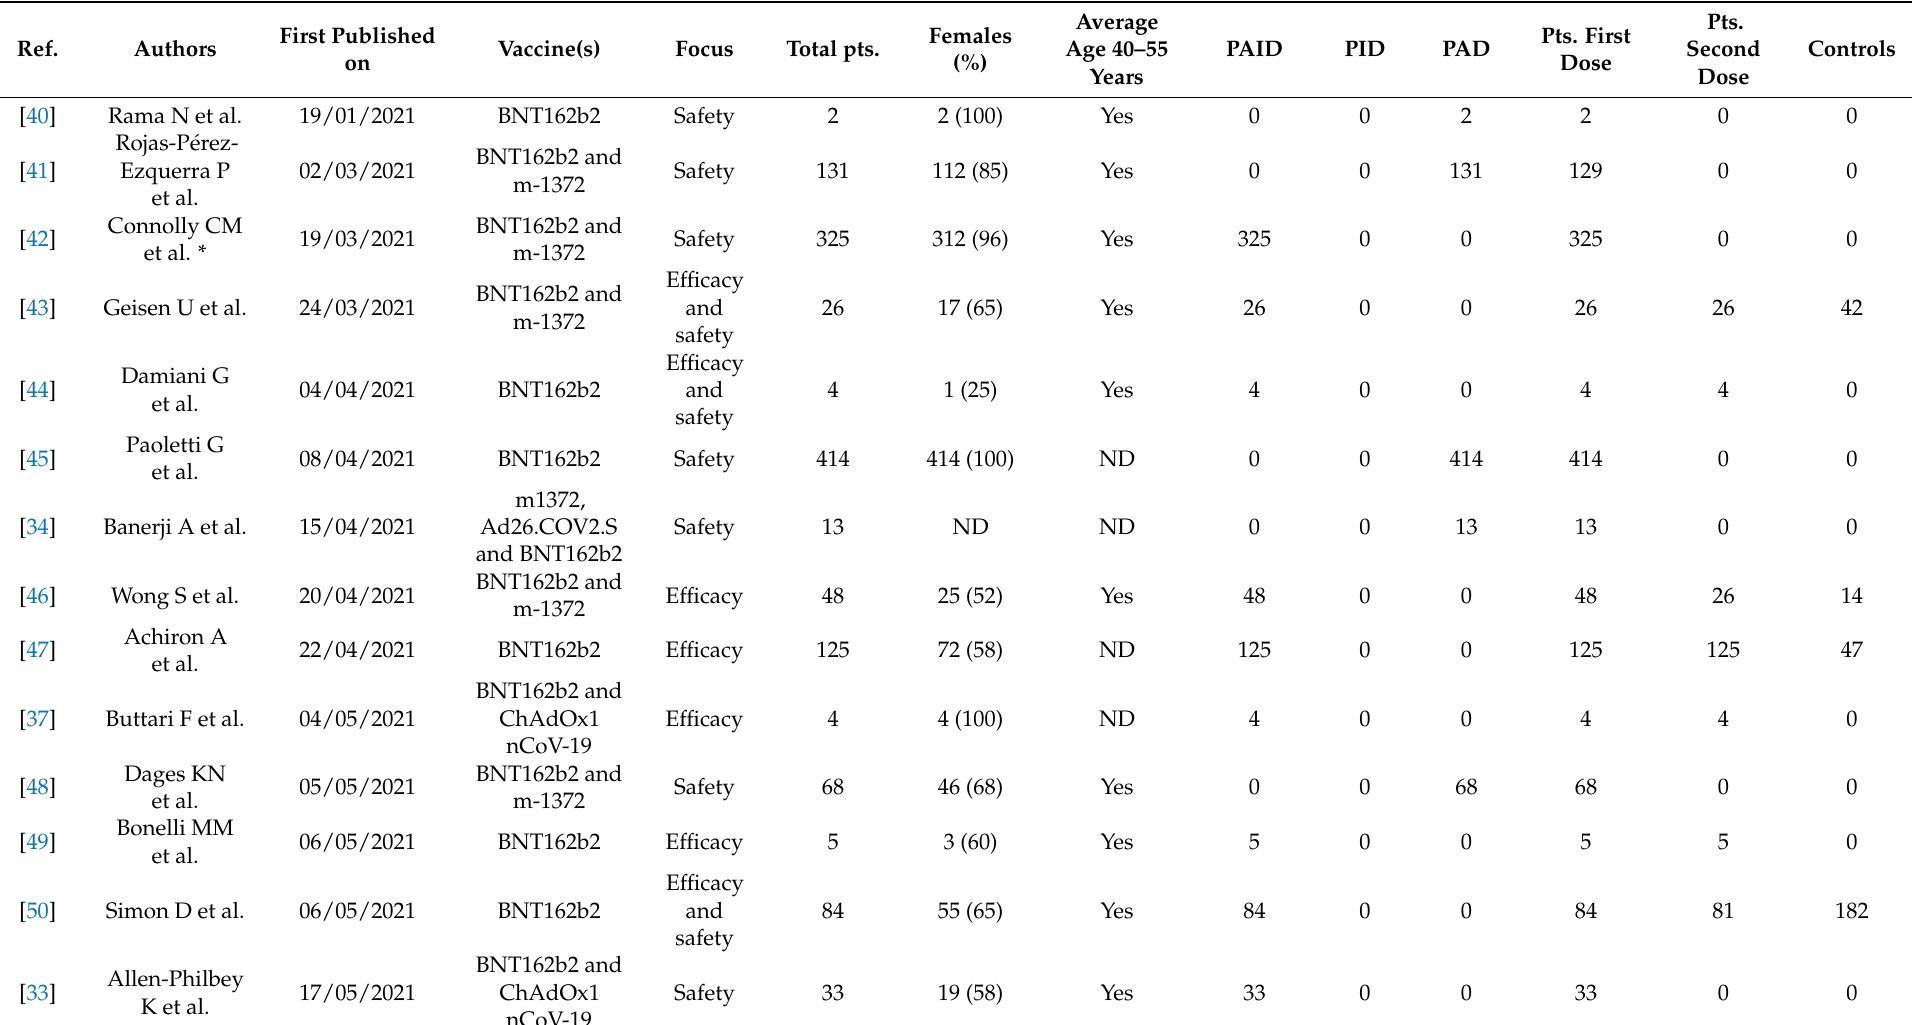
Table 1. General features of published studies on SARS-CoV-2 vaccines in patients with immune-mediated diseases.